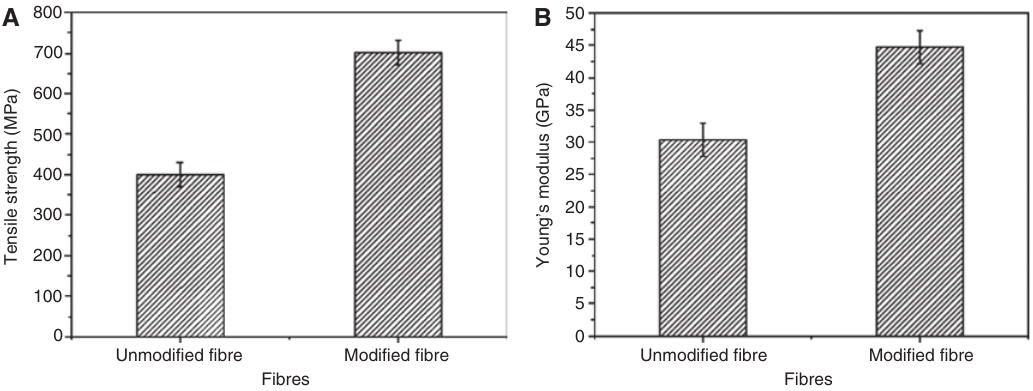
Figure 9: Tensile strength (A) and tensile modulus (B) of unmodified and FCuNPs modified flax fibers.